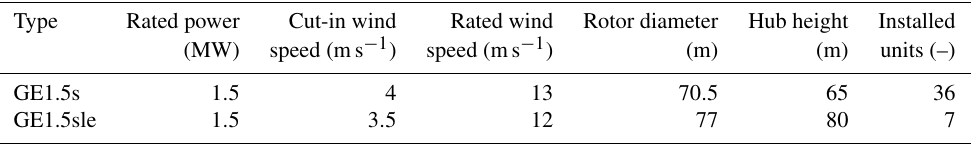
Table 5. Turbine